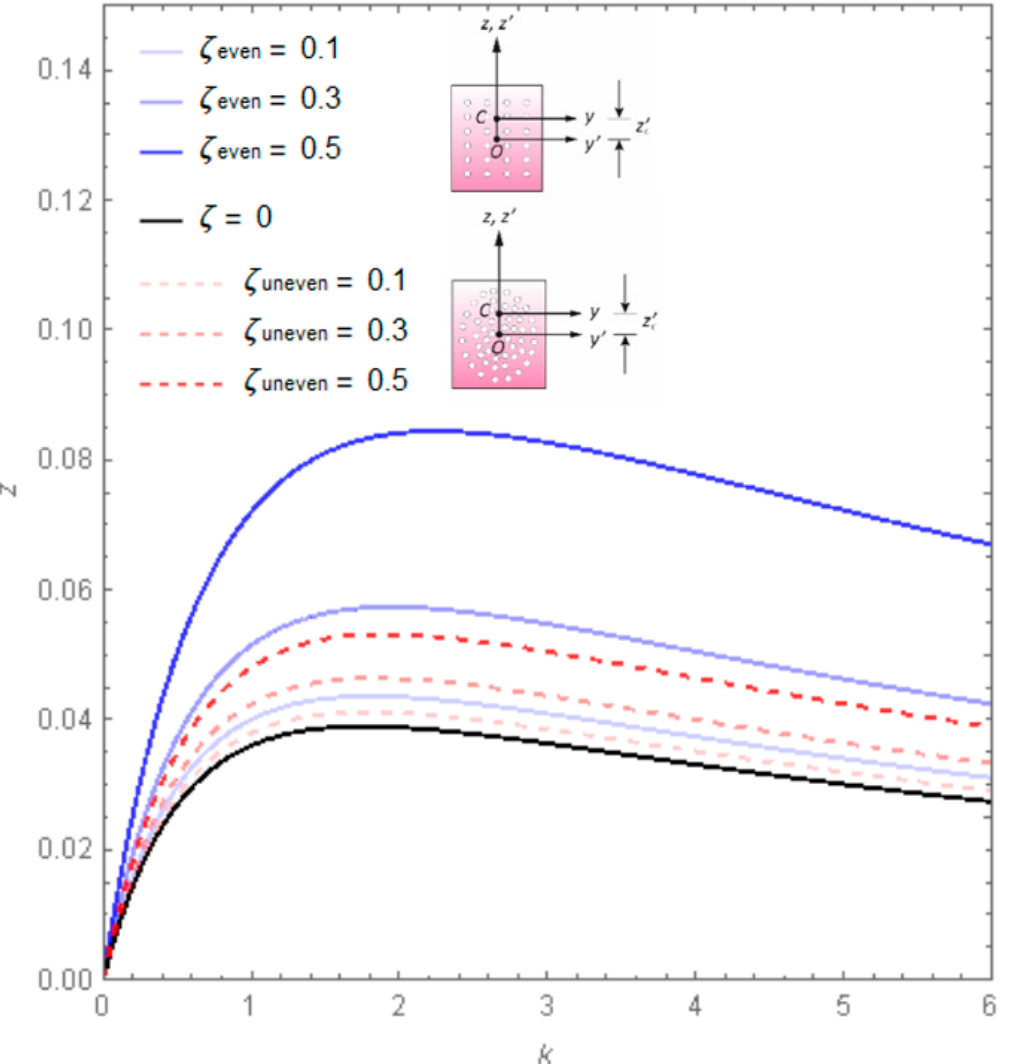
Figure 2. E ff ect of the gradient index of the FG material ( k ) on the dimensionless position of the elastic Figure 2. Effect of the gradient index of the FG material ( 𝑘 ) on the dimensionless position of the elastic center C ( (cid:101) z c = z (cid:48) c / h ) of the rectangular cross section of the FG nano-beam, varying the porosity volume center C ( 𝑧̃ (cid:3030) = 𝑧 (cid:3030)(cid:4593) /ℎ) of the rectangular cross section of the FG nano-beam, varying the porosity fraction ( ζ ): even distribution (continuous lines) and uneven distribution (dashed volume fraction ( 𝜁 ): even distribution (continuous lines) and uneven distribution (dashed lines).